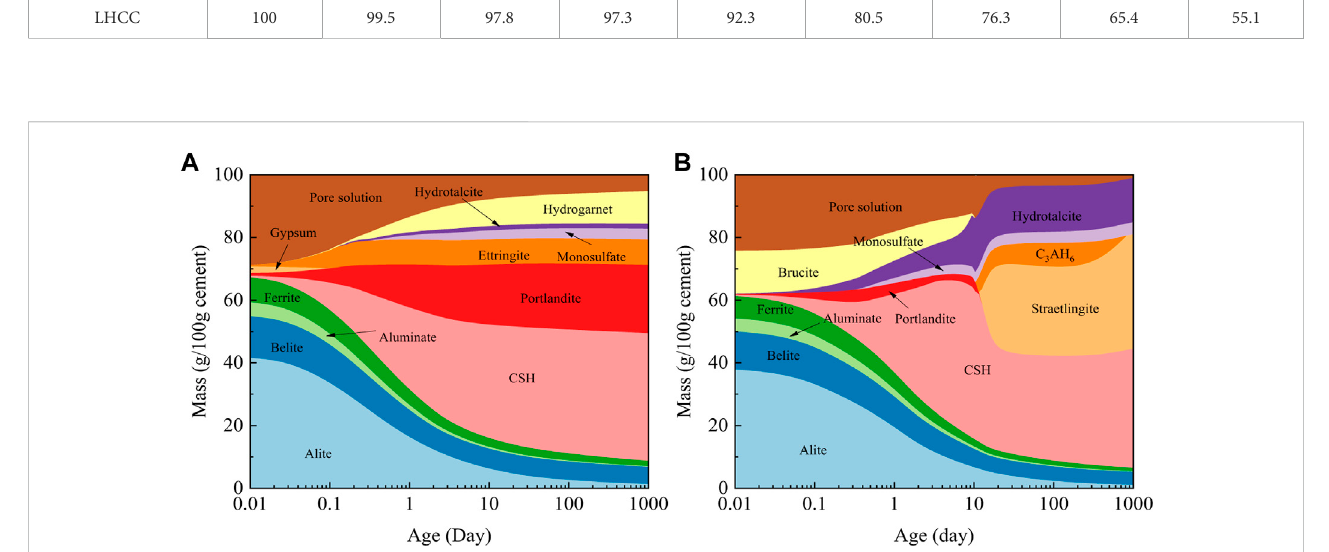
FIGURE 4 Phase evolution of (A) PC and (B) LHCC by thermodynamic simulation.